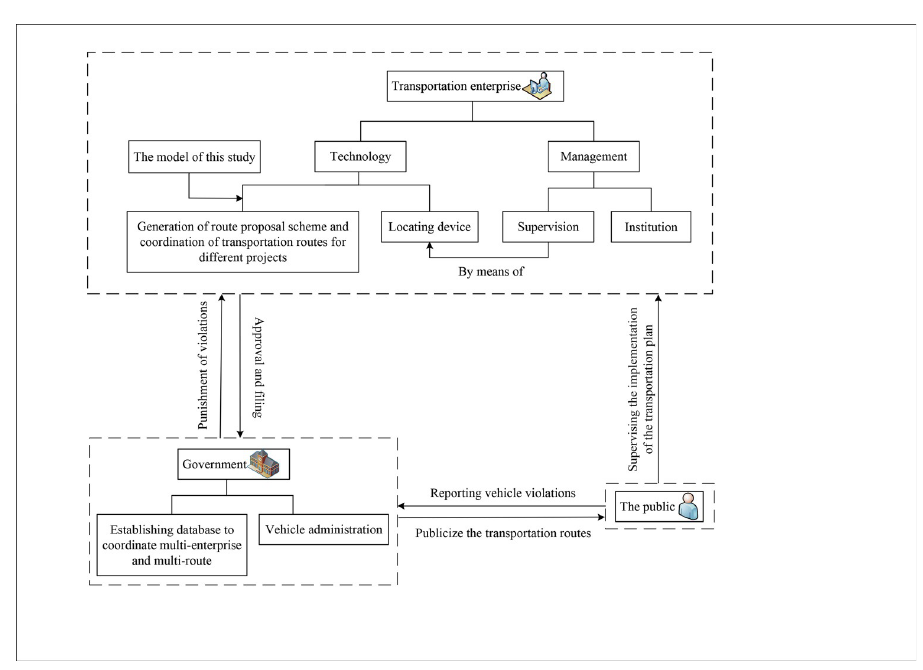
Fig 8. Management mechanism of transportation